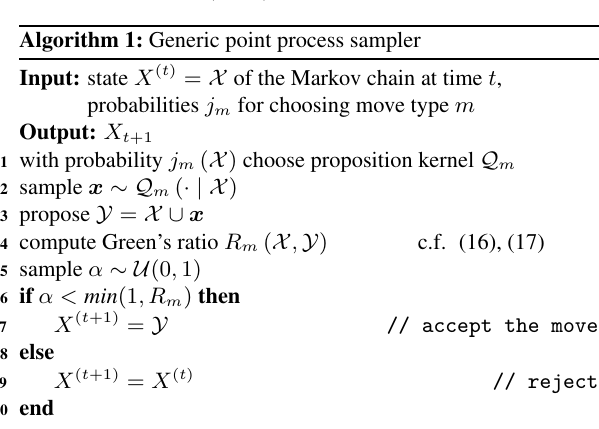
Algorithm 1: Generic point process